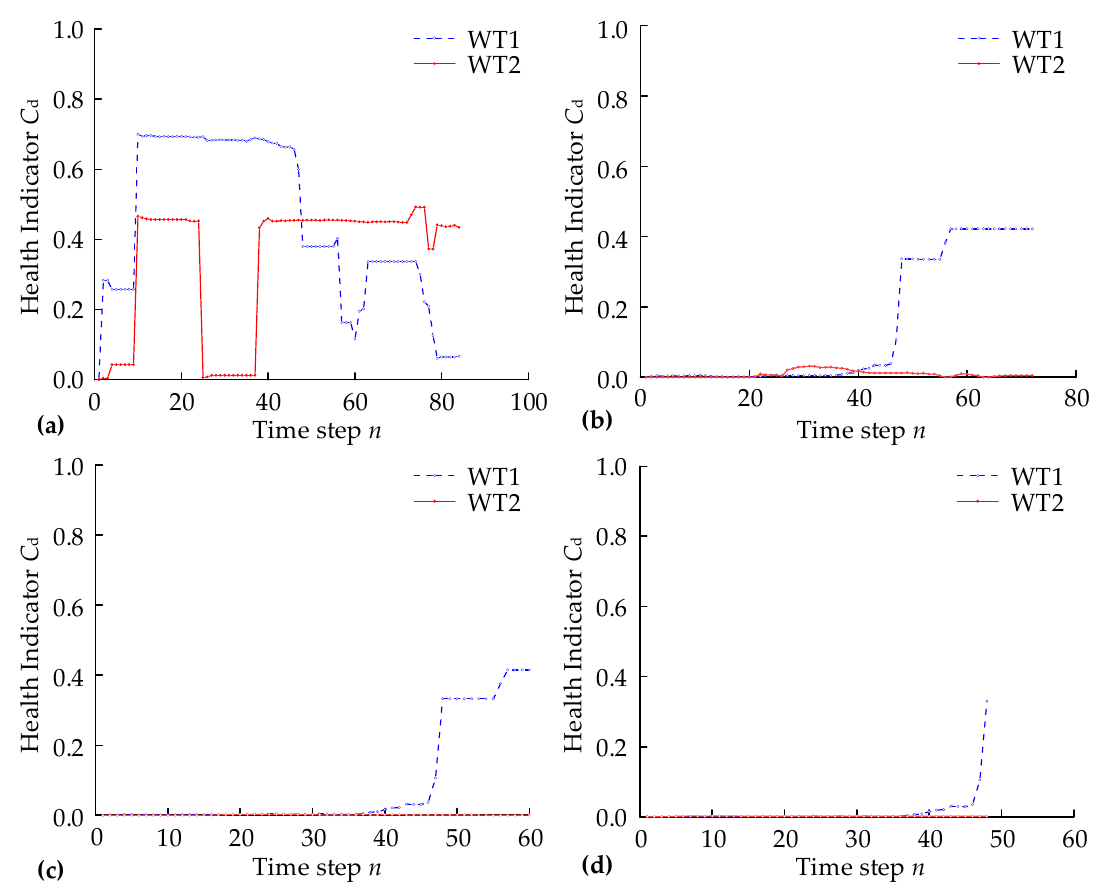
Figure 9. Health indicators of WT1 under di ff erent window widths: ( a ) h = 12 h, total time step n = 85; ( b ) h = 24 h, total time step n = 73; ( c ) h = 36 h, total time step n = 61; ( d ) h = 48 h, total time step n = 49.